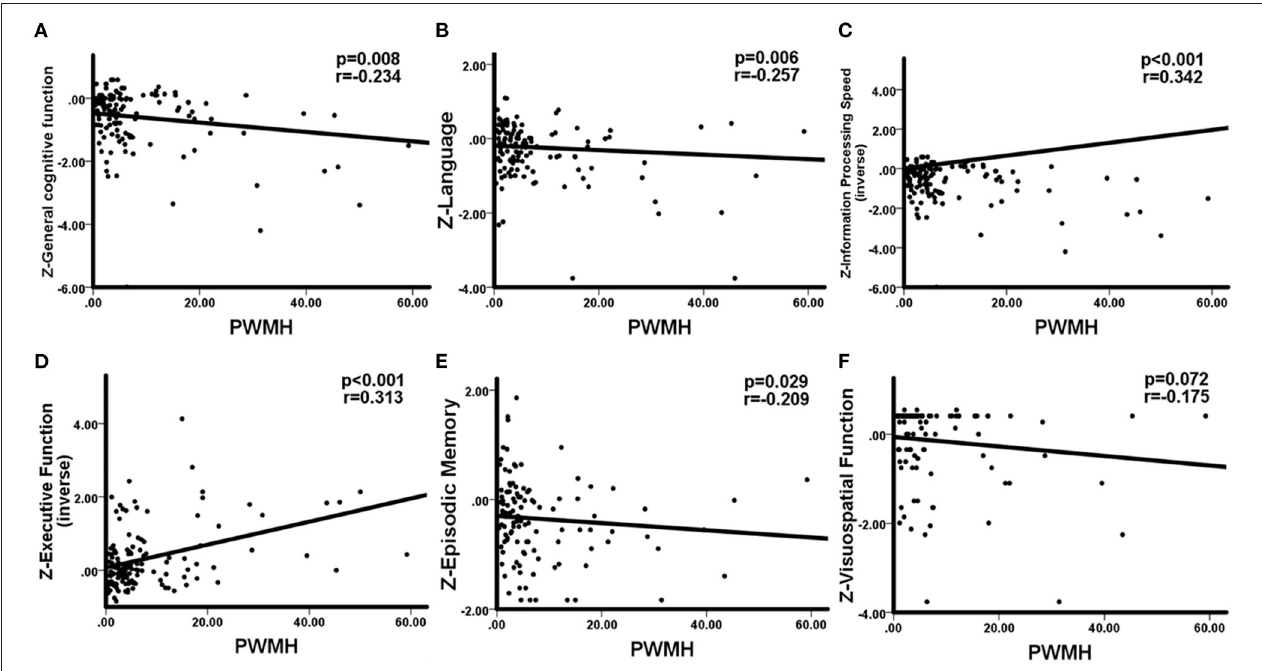
FIGURE 2 | Correlations between PWMH and cognitive function in CSVD-CI patients. Partial correlation was conducted by controlling for age, gender, years of education, history of hypertension, and history of LI/TIA in CSVD-CI group. (A) Increased PWMH volume was associated with worse general cognitive function. (B) Larger PWMH volume showed significant impairment in the language domain. (C) Information processing speed was negatively associated with increased PWMH volume. (D) PWMH volume had a negative correlation with executive function. (E) PWMH volume correlated negatively with episodic memory. (F) No significant correlation was observed between PWMH volume and visuospatial function. PWMH, periventricular white matter hyperintensities; CSVD-CI, cerebral small vessel disease patients with cognitive impairment; TIA, transient ischemic attack; LI, lacunar